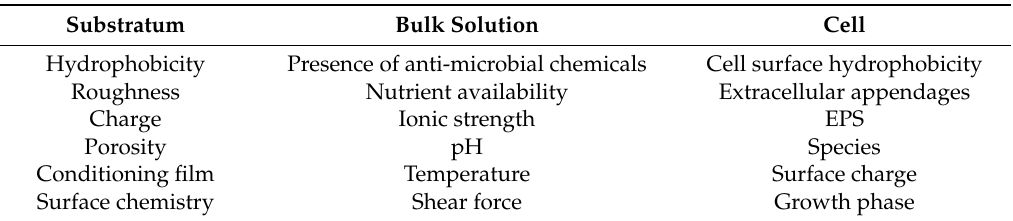
Table 1. Factors contributing to microbial attachment. Adapted from [78]. EPS: extracellular polymeric